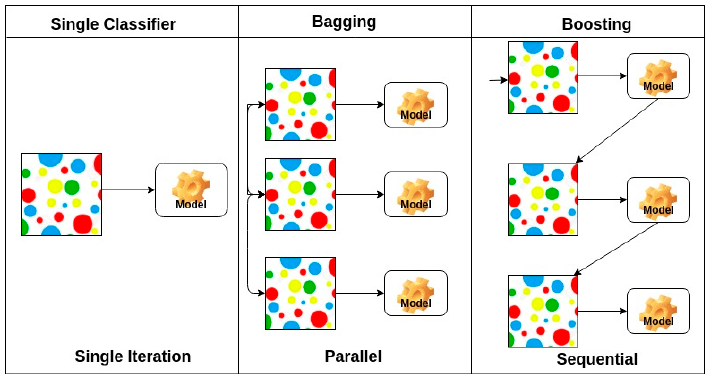
Figure 5. Ensemble learning, bagging, and boosting machine learning techniques [28].